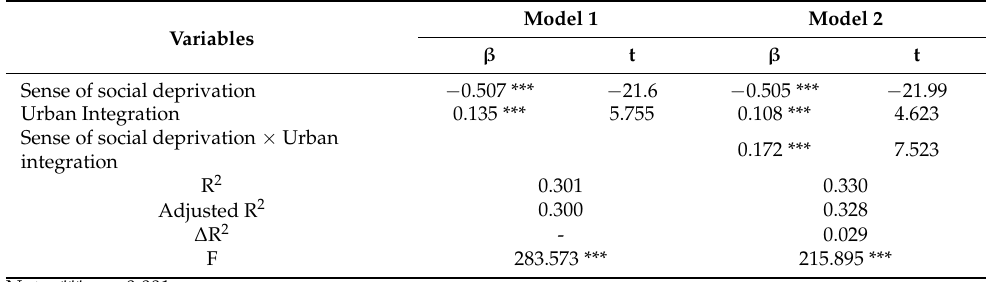
Table 14. The moderating effect of urban integration on the relationship between social deprivation and willingness to withdraw.